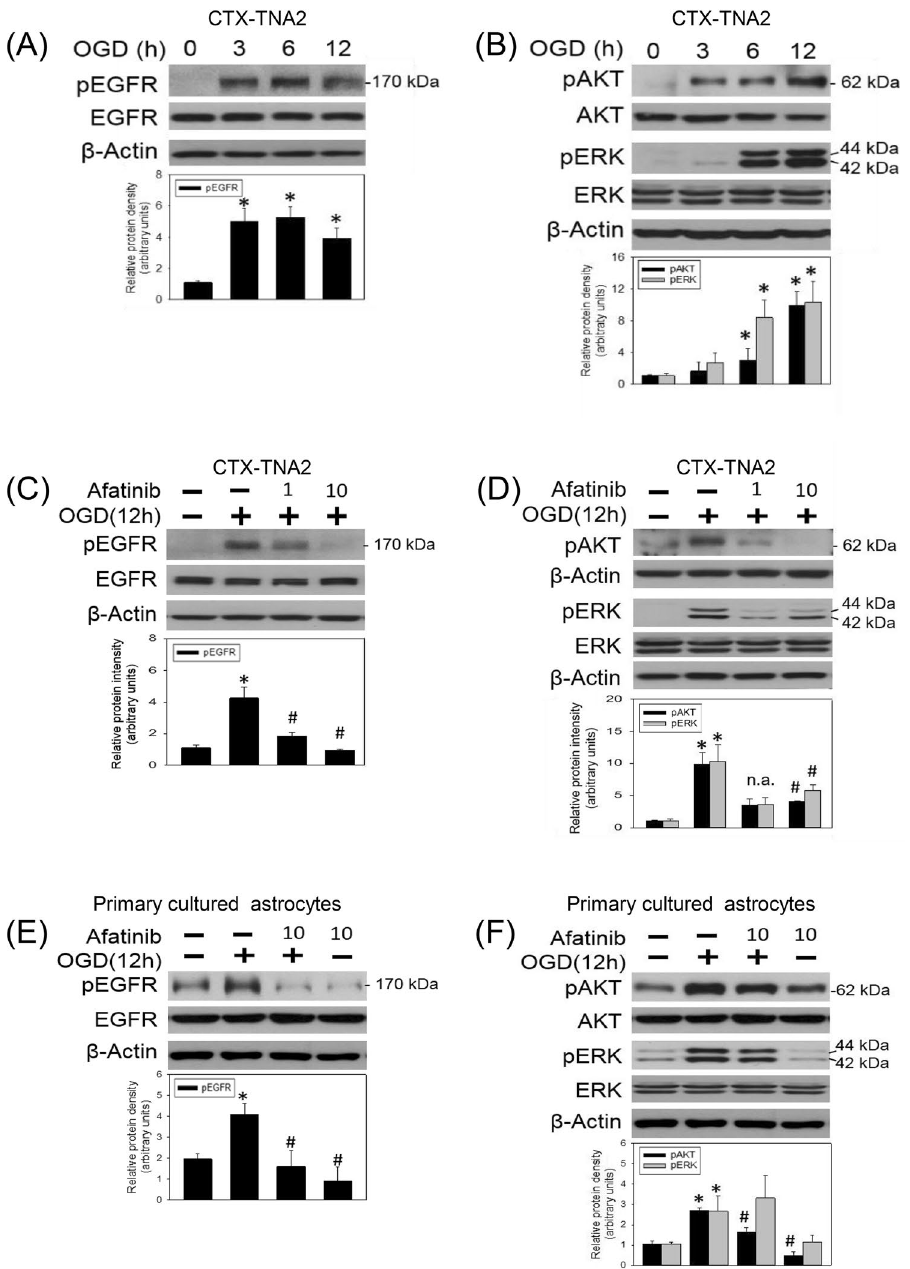
Figure 1. A corrected version of the original Figure 2. Afatinib blocked OGD-induced EGFR activation and downstream signalings. ( A , B ) CTX-TNA2 cells were exposed to oxygen-glucose deprivation (OGD) for various durations (3, 6, 12 h). Western blot assay was employed to measure ( A ) the levels of phospho-EGFR (pEGFR) and total-EGFR (EGFR) as well as ( B ) phospho-ERK (pERK), total-ERK (ERK), phospho-AKT (pAKT), total- AKT (AKT) and β-Actin. Each lane contained 40 μg protein for all experiments. Graphs show statistical results of pEGFR ( A ) as well as pERK and pAKT ( B ) from relative optical density of bands on the blots. *P < 0.05 in the OGD group compared with the control by t-test. ( C , D ) CTX-TNA2 cells were exposed to OGD for 12 h. Afatinib (1, 10 nM) was included in the culture medium concomitantly with OGD exposure. ( E , F ) Primary cultured astrocytes were exposed to OGD for 12 h. Afatinib (10 nM) was included in the culture medium concomitantly with OGD exposure. Graphs show statistical results of pEGFR ( C , E ) as well as pERK and pAKT ( D , F ) from relative optical density of bands on the blots. Values are the mean ± S.E.M. (n = 3/group). n.a. is not applicable because these experiments were performed only in duplicate (n = 2) and so the comparison was not performed. *P < 0.05 in the OGD group compared with the control, # P < 0.05 in OGD plus afatinib compared with OGD alone by Kruskal-Wallis test and followed by Mann-Whitney U test as post-hoc